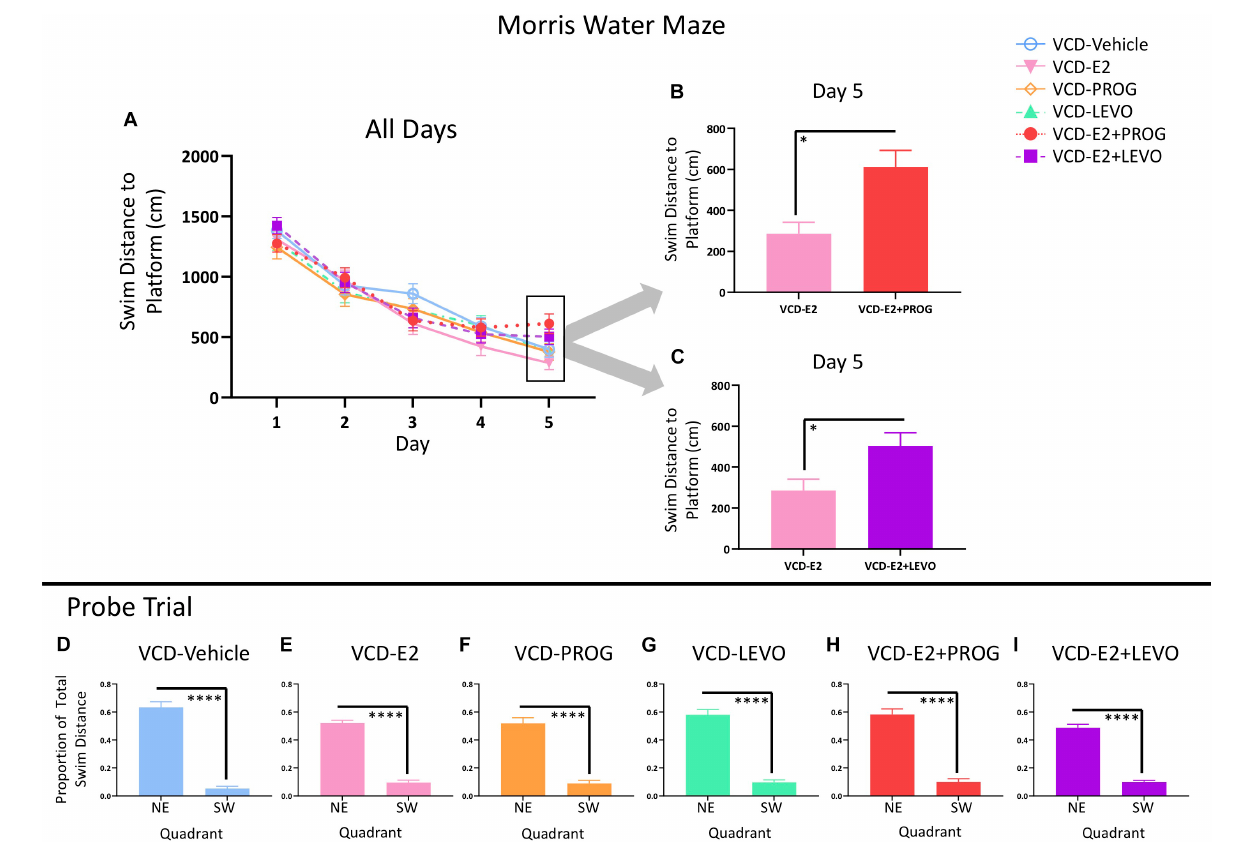
FIGURE 8 | Morris Water Maze. (A) Swim Distance to Platform Across All Days. (B) VCD-E2 treated rats swam less distance to the platform compared to the VCD-E2 + PROG treated rats ( p < 0.05). (C) VCD-E2 treated rats swam less distance to the platform compared to the VCD-E2 + LEVO treated rats ( p < 0.05). (D–I) Probe trial. All treatment groups swam a greater proportion of total distance in the previously platformed quadrant vs. the opposite quadrant, indicating that all groups spatially localized to the hidden platform location. Significance: ∗ = p < 0.05, ∗∗∗∗ p < 0.0001.